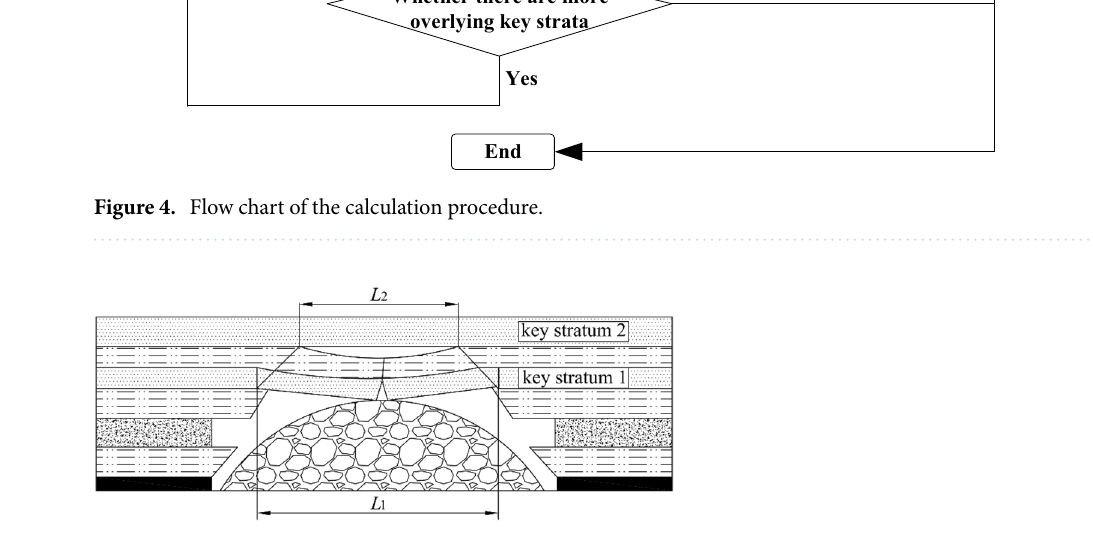
Figure 5. Schematic diagram of key strata breaking (This figure is drawn by the AutoCAD 2018, https:// www. autod esk. com. cn/ produ cts/ autoc ad/ overv iew? term=1- YEAR& tab= subsc ripti